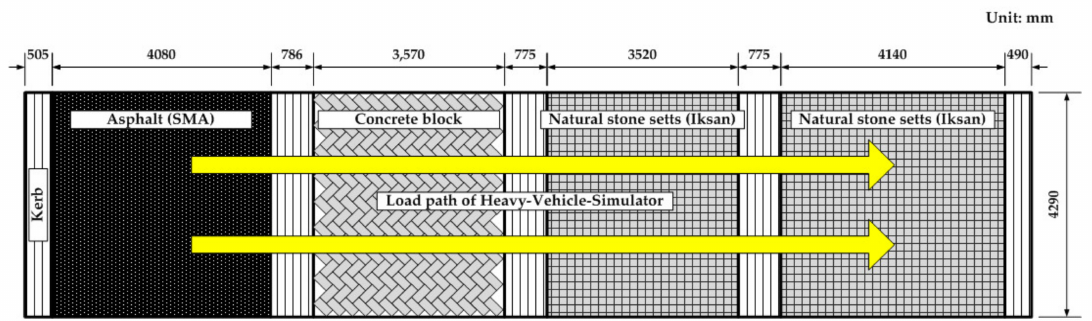
Figure 2. Korea Accelerated Loading Environment Simulator and history of equivalent single axle loads (ESALs).